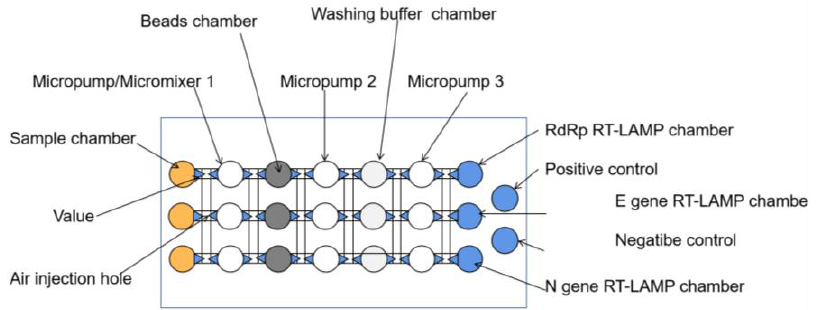
Figure 7. Schematic of the main components of the microfluidic chip [53].